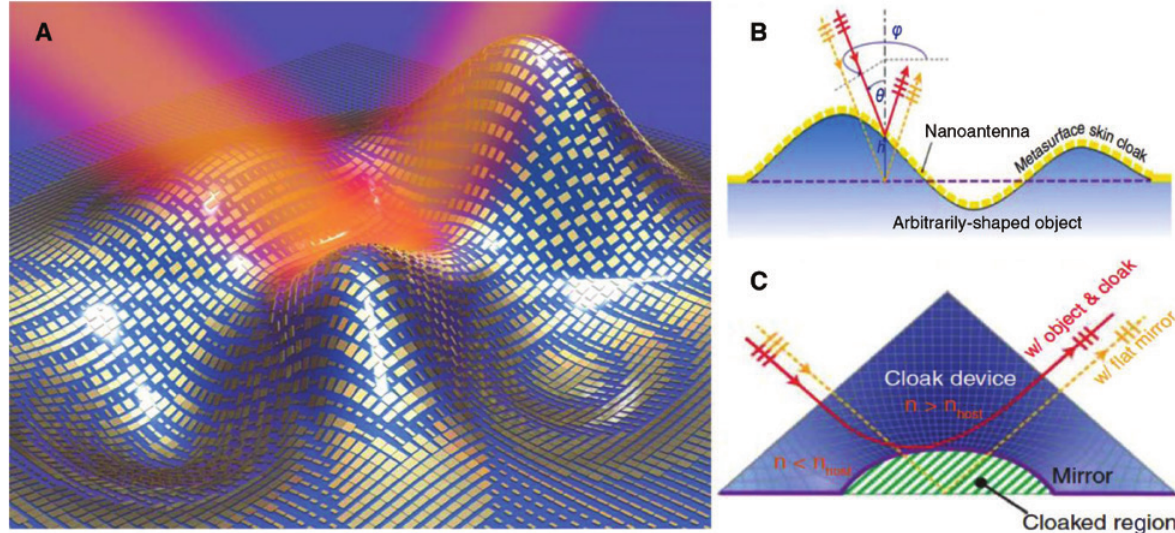
Figure 5: Schematic view and working principle of a metasurface skin